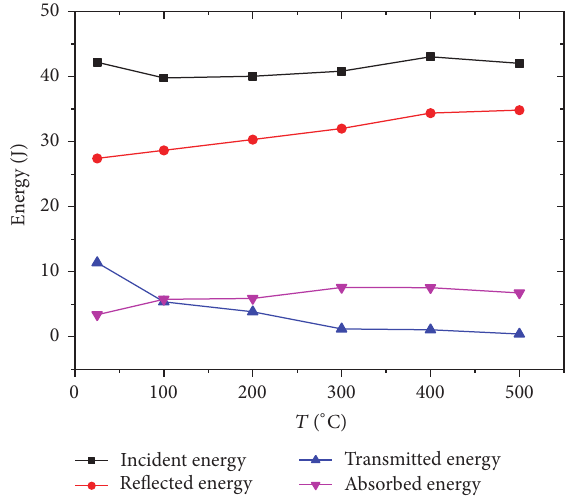
Figure 6: The evolution of energy at different